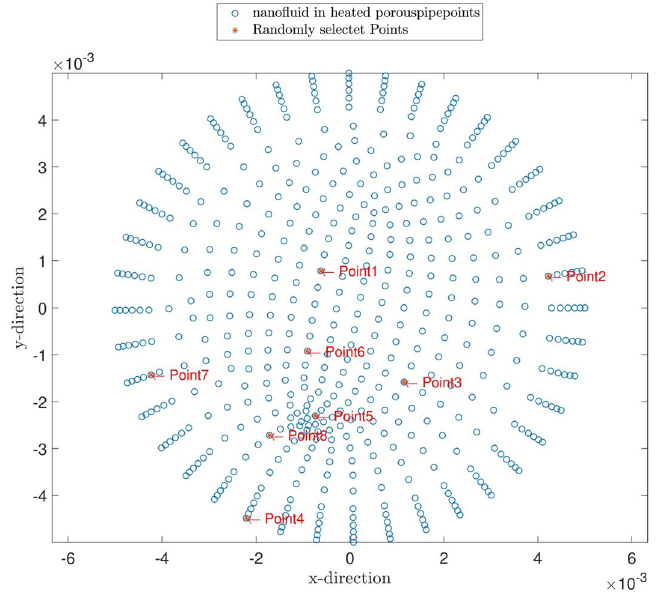
Figure 12. Random selected points for prediction of temperature in different nanoparticle fractions.